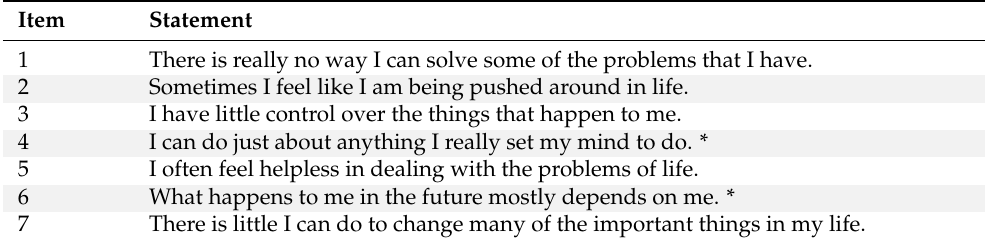
Table A1. Items in Pearlin and Schooler’s (1978) Mastery Scale